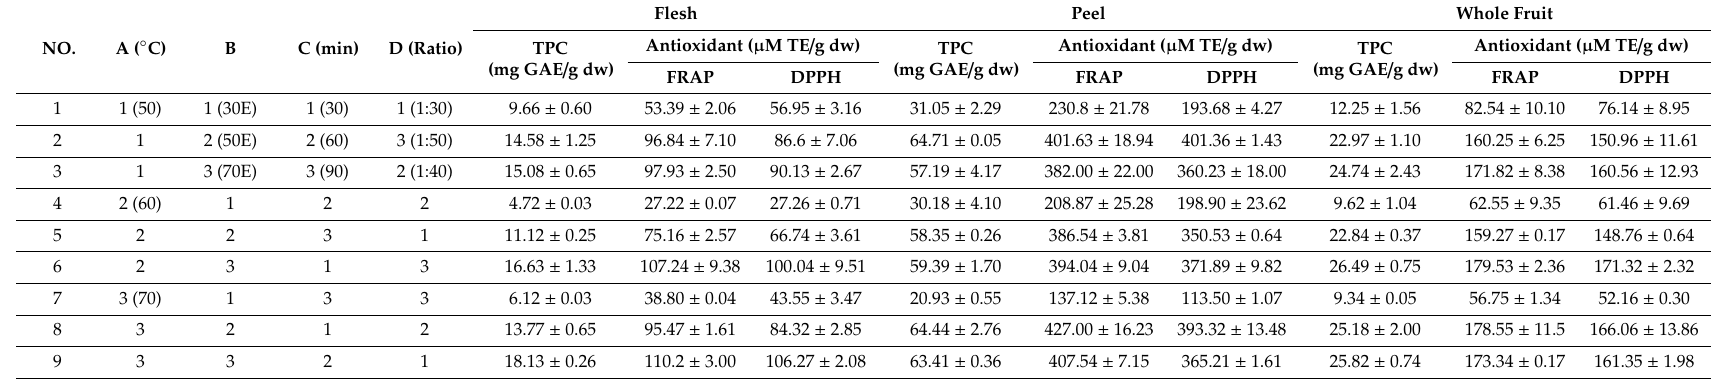
Table 1. Orthogonal design L9 (3 4 ) and results for ethanol extraction of phenolic compounds from feijoa flesh, peel and whole